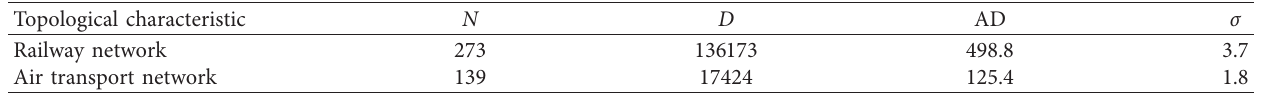
Table 2: Topological characteristics of China railway and air transport networks.